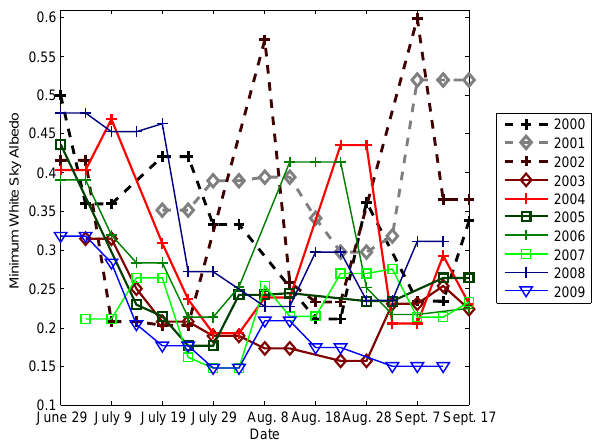
Fig. 5. Minimum white sky albedo retrieved from MODIS data in the ablation zone for summers 2000–2009. This figure shows the evolution of the minimum albedo of one pixel of the ablation zone, the crossed pixel in Fig. 4. It shows minimum value of albedo over 10 days each 5